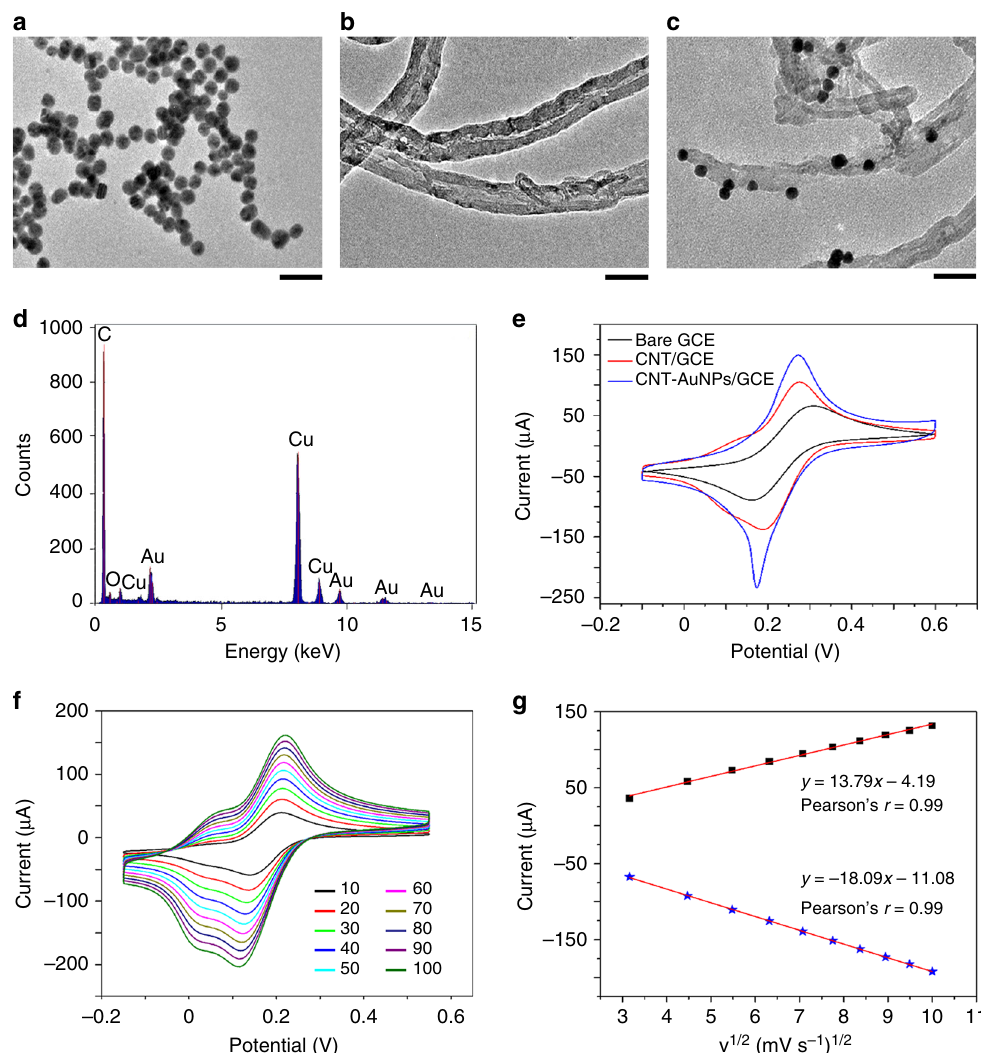
Fig. 2 Characterization of the electrochemical performance of the modi fi ed electrode. a – c Transmission electron microscopy images of AuNPs a , CNT b , and CNT-AuNPs c . Scale bar, 50 nm. d X-ray diffraction pro fi les of CNT-AuNPs. e Cyclic voltammetry curves of bare GCE, CNT/GCE, and CNT-AuNPs/ GCE recorded in 10 m M K 3 [Fe(CN) 6 ] at a scan rate of 50 mV s − 1 . f Kinetic analysis of CNT-AuNPs/GCE at scan rates ranging from 10 to 100 mV s − 1 indicating that reaction of the modi fi ed electrode is a diffusion-controlled surface reaction. g Linear fi ts of the oxidized peak current (Ipa) and reduced peak current (Ipc) versus the square root of the scan rate (v